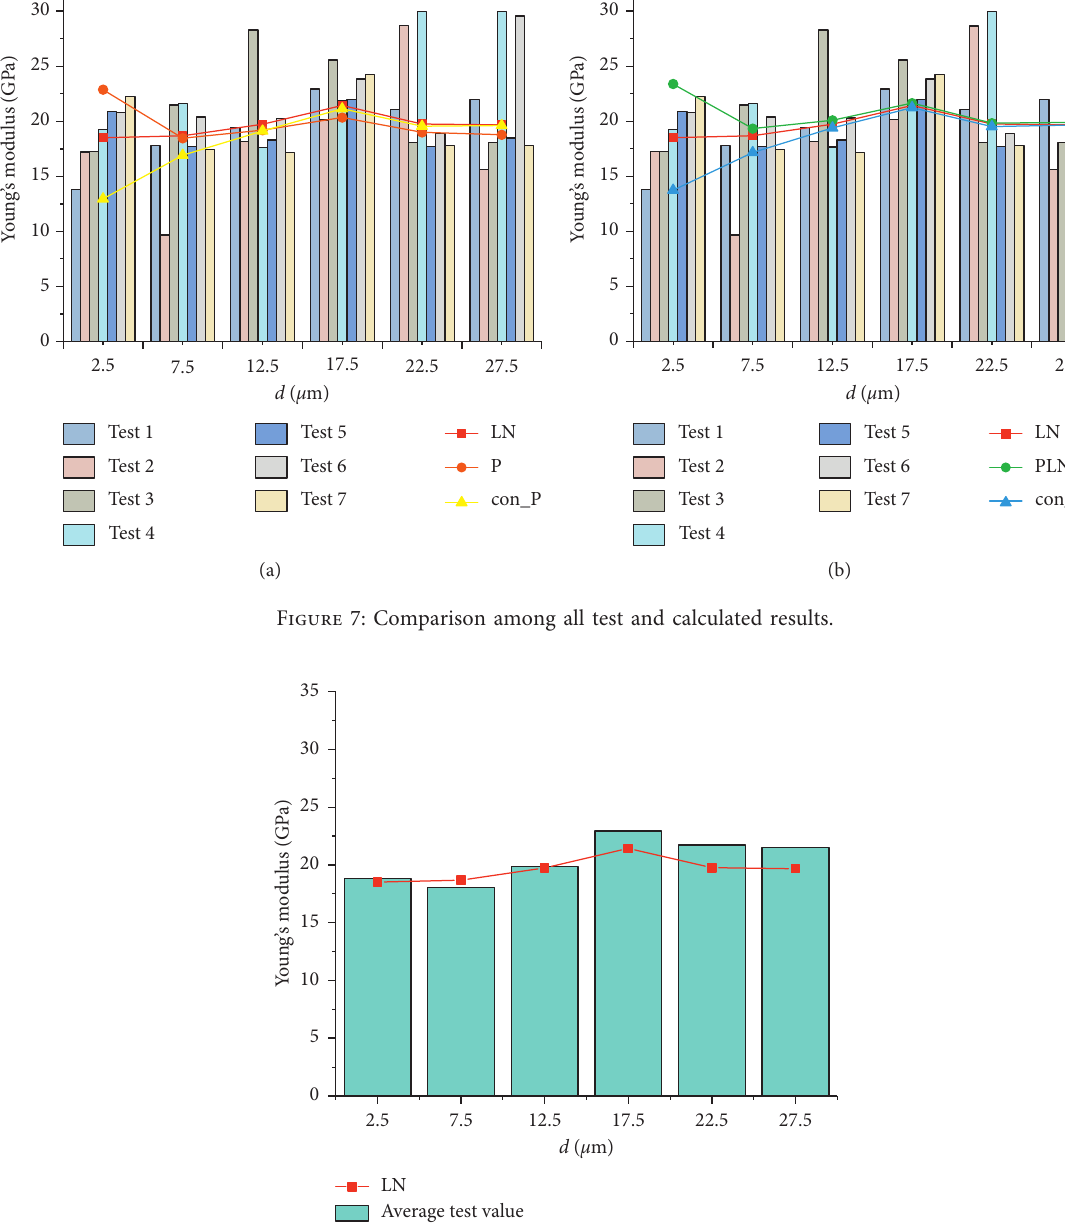
Figure 8: Comparison between test average results and calculated results assuming LN distribution of CH voids. Table 5: Deviation of average ITZ Young’s modulus.